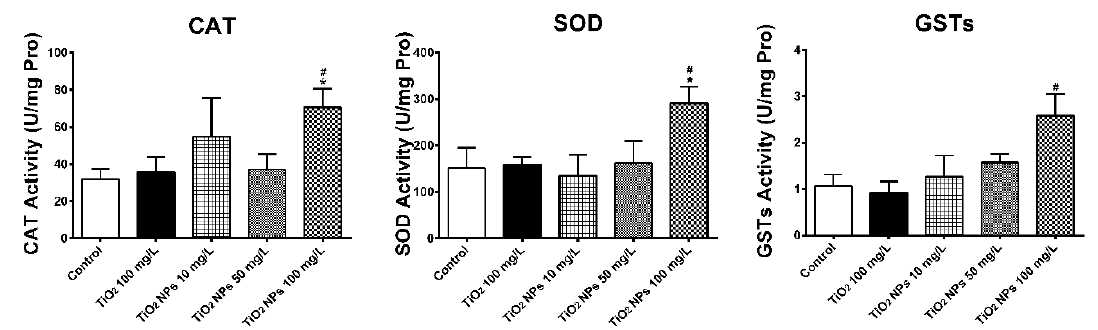
Figure 5. CAT, SOD and GSTs activities in zebrafish intestinetissue. Data are expressed as means ± SD ( n = 3). * indicate statistically significant differences from control values at p < 0.05. # indicate statistically significant differences from TiO 2 (100 mg/L) values at p < 0.05.